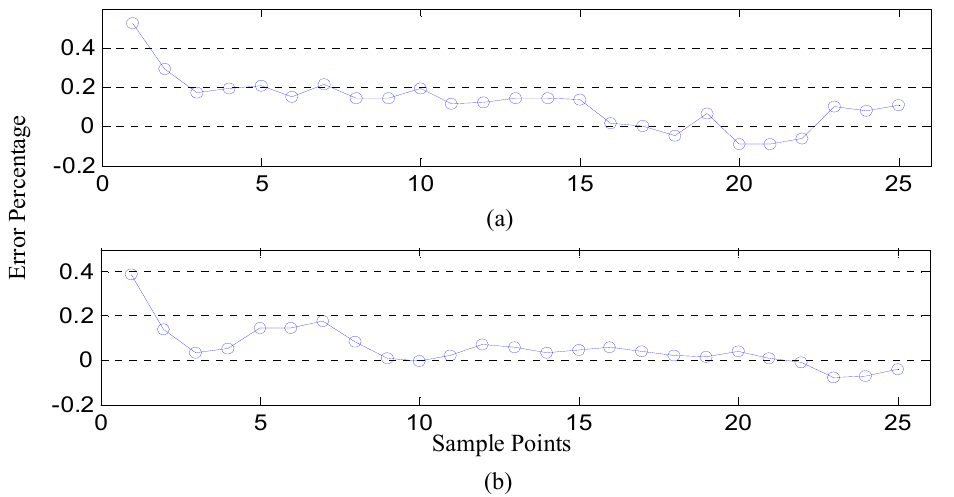
Figure 8. Comparison of the influence of dimensionality reduction on model prediction error: ( a ) prediction error of the wavelet-BP neural network model without dimensionality reduction and ( b ) prediction error of the wavelet-BP neural network model after dimensionality reduction.